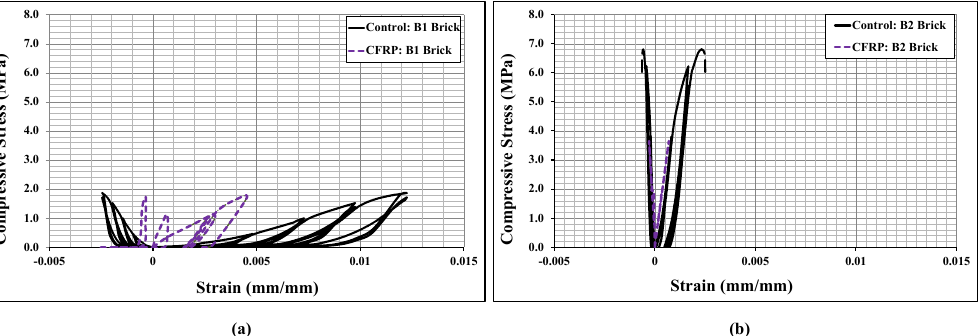
Figure 17. Stress-strain curves of the CFRP-strengthened cyclic loaded wallettes constructed using ( a ) B1 and ( b ) B2 Bricks tested under cyclic loading.